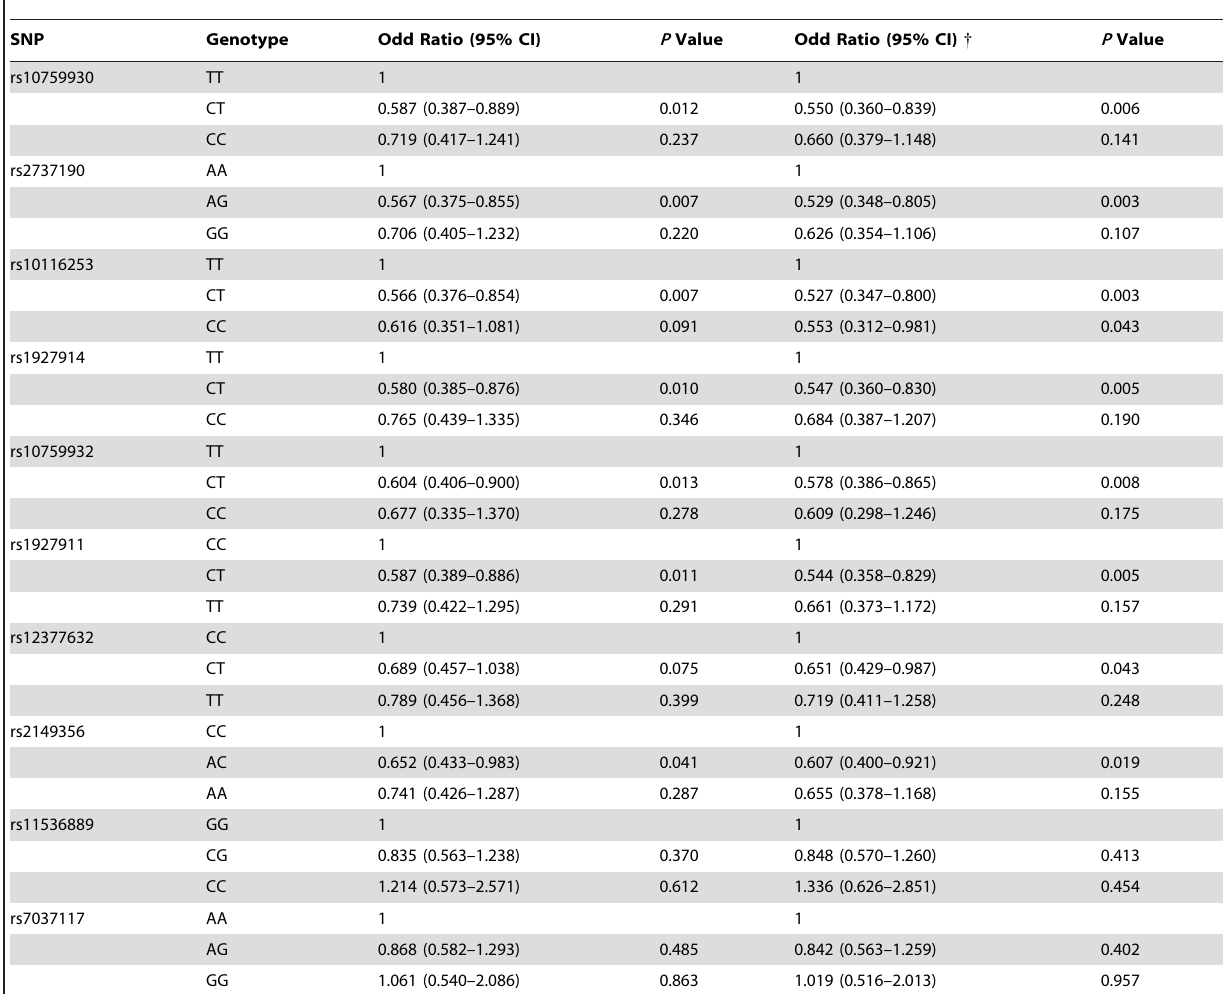
Table 3. Association between hepatocellular carcinoma and TLR4 single nucleotide polymorphisms.